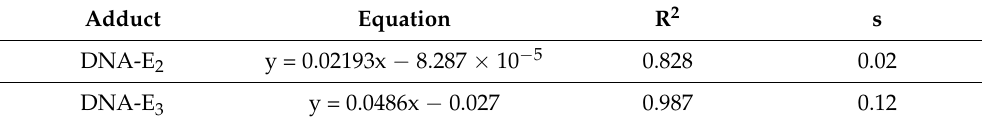
Table 4. Values of binding site size obtained using the plot of Cb/Cf versus (DNA). Adduct